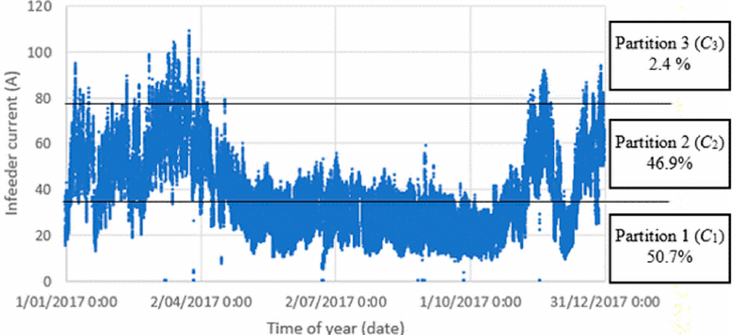
Figure 1. Historical infeeder loading data for the real distribution network analysed in the case studies. Load partitions are shown, as well as the percentage of time for which they occur. The partition containing the highest measurement count represents the current magnitude range that flows through the substation for the largest percentage of the year. The average within this partition is the infeeder current that is divided amongst each of the load buses in the network using a load allocation method (in this case, PSS SINCAL). The optimal tap positions are calculated for this loading case. Furthermore, to account for the random nature of the ES, the optimal tap positions are calculated three times for randomly determined initial tap settings. The objective function of the median tap positions across these trials is then calculated and compared to the objective function of each individual trial. The set of taps that produce the minimum objective function corresponds to the optimal set of taps for the network under this loading case. This method is preferred to selecting the average infeeder current to allocate loads as it is more robust against extreme loading cases. Once calculated, these tap settings are applied to each of the original loading partitions to examine how the settings perform over an entire year. Since loads vary, Monte Carlo simulations can be used to capture this performance. The historical infeeder loading data can be sampled and allocated to the network buses. Each loading partition is sampled separately. The risk of voltage violation is then calculated, and is defined as the percentage of time the feeder would have voltages outside voltage constraints when the optimal tap settings are applied. Consider partitions C 1 , C 2 and C 3 which make up x %, y % and z % of the historical infeeder loading throughout one year respectively. The average infeeder loading of the partition with the highest percentage is calculated. This average is used to allocate the load on each bus using a load allocation scheme, and the subsequent network loading is used to calculate the optimal tap settings. Then, N max Monte Carlo simulations are completed by applying the optimal set of taps to sample loading scenarios from each partition separately. For each simulation, let N 1 , N 2 and N 3 be the number of simulations that fall outside the voltage constraints for partitions C 1 , C 2 and C 3 , respectively. Then, the risk R of the feeder violating constraints with the optimal set of taps as a percentage is: